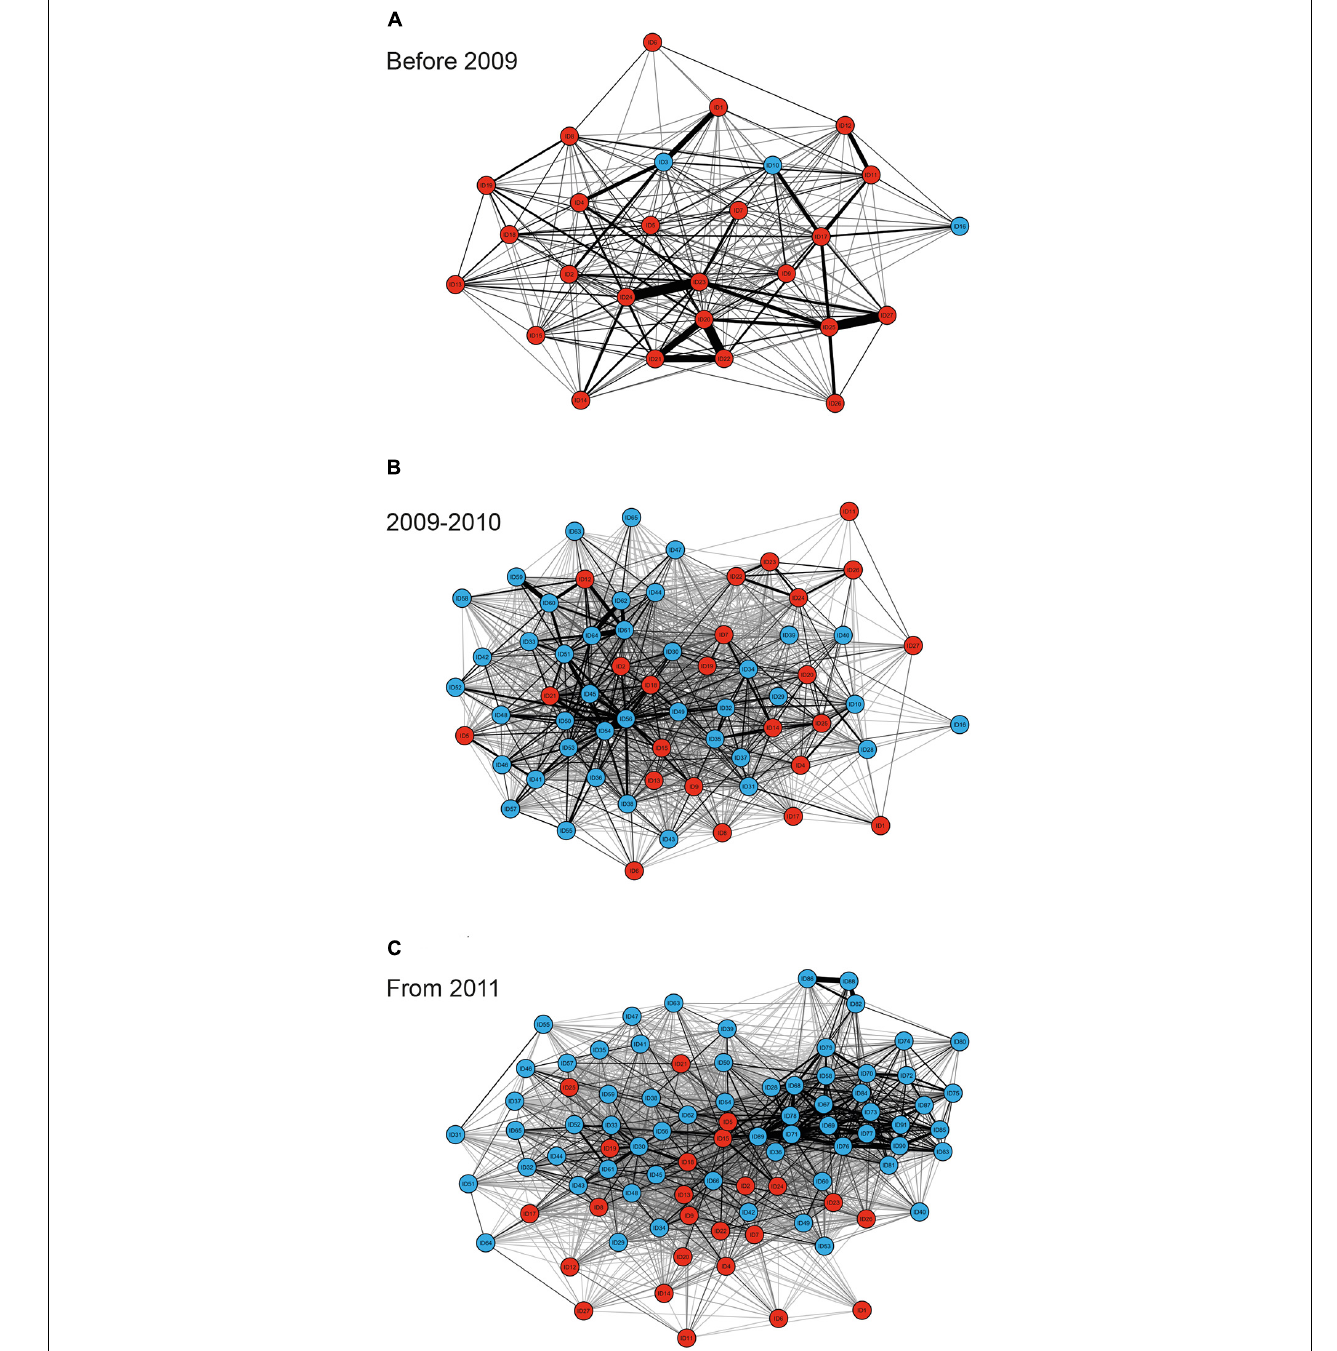
FIGURE 1 | Sociograms depicting the social ties between individual bull sharks observed on the study site on ≥ 34 dives for the time periods before 2009 (A) , between 2009 and 2010 (B) , and from 2011 (C) . Only GAI values in the highest 30% were included to highlight the strongest associations between dyads, with thicker edges indicating higher GAIs for both individuals observed throughout the entire sampling period (red nodes), and individuals which were not observed throughout the entire sampling period (blue nodes).